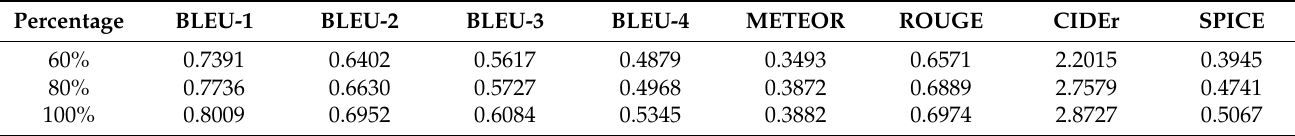
Table 6. Percentage sampling experimental results on RSICD dataset.